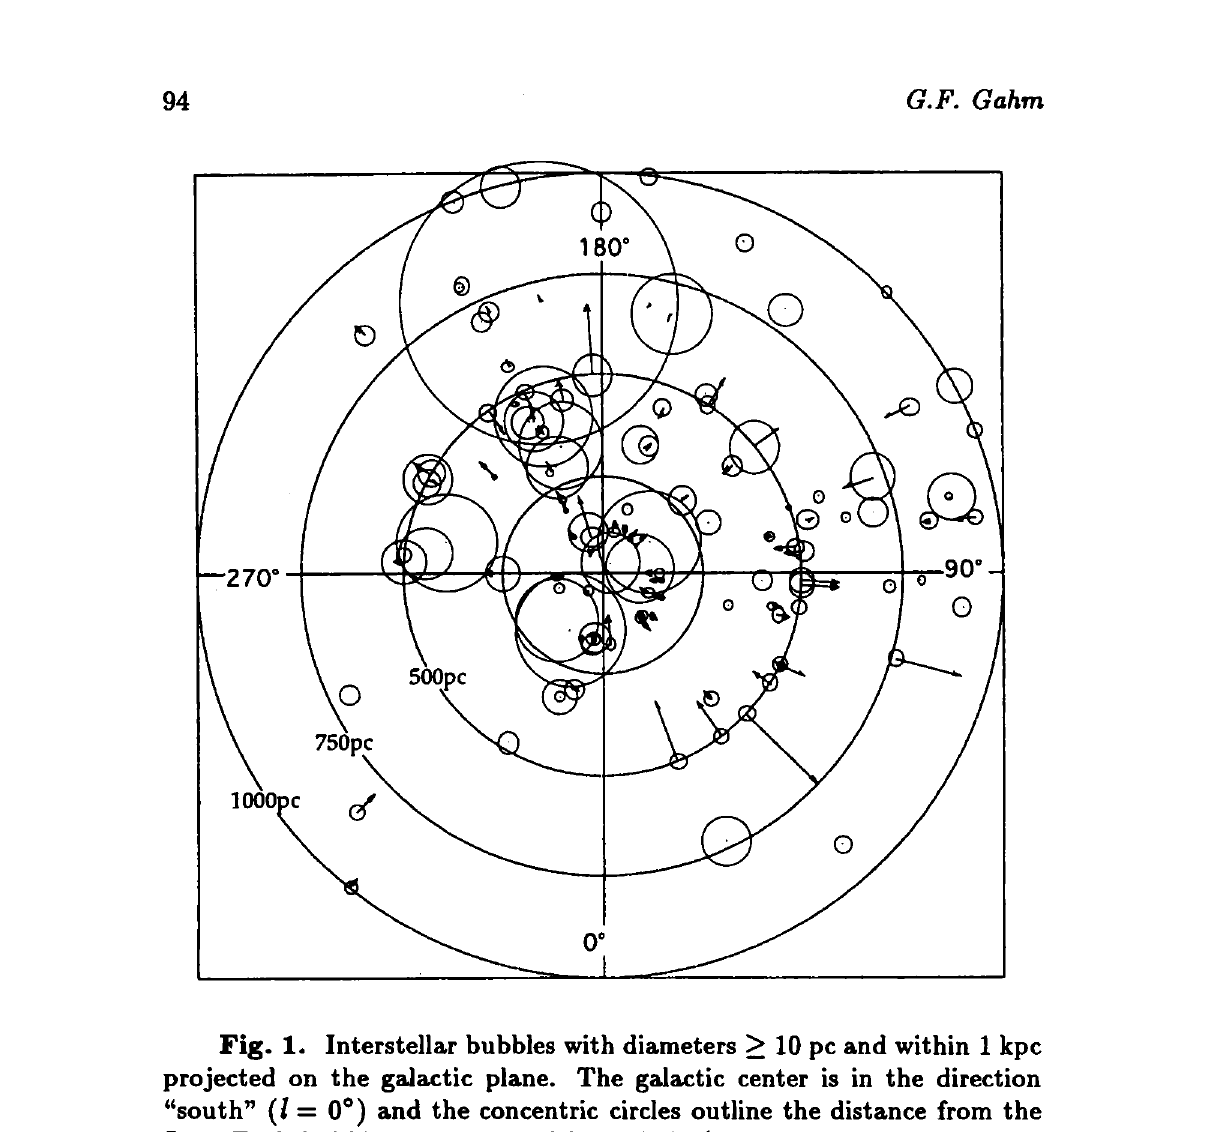
Fig. 1. Interstellar bubbles with diameters > 10 pc and within 1 kpc projected on the galactic plane. The galactic center is in the direction "south" ( / = 0°) and the concentric circles outline the distance from the Sun. Each bubble is represented by a circle (even if the shapes normally are much more irregular). The central radial velocity is indicated by a vector; the scale is given in the 3rd quadrant. The Gould's Belt system is not